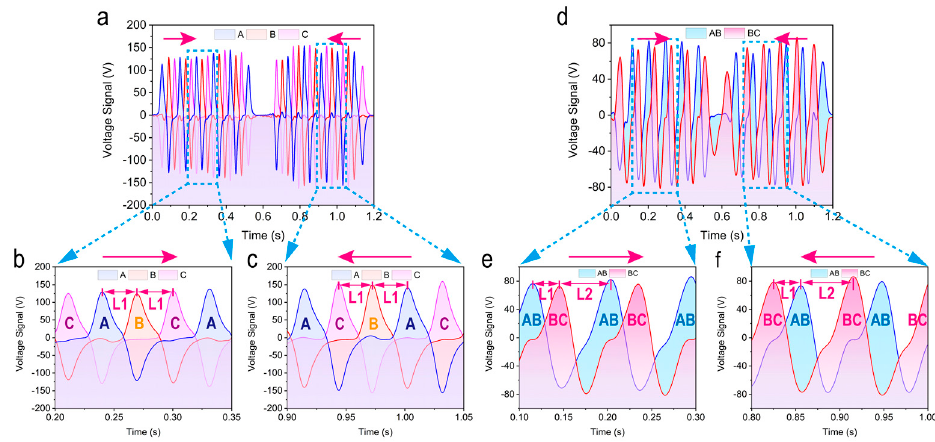
Figure 5. Characterizing the performance of strip-shaped SPVS. ( a ) Electrical performance of SPVS as the slider slide to the left ( b ) and ( c ) to the right under the first detection mode. ( d ) Electrical performance of SPVS as the slider slide to the left ( e ) and ( f ) to the right under the second detection mode.